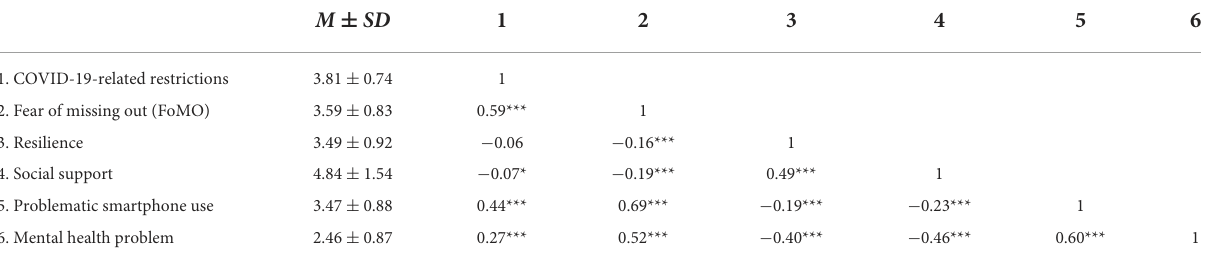
TABLE 2 Correlations and means of study variables ( N =